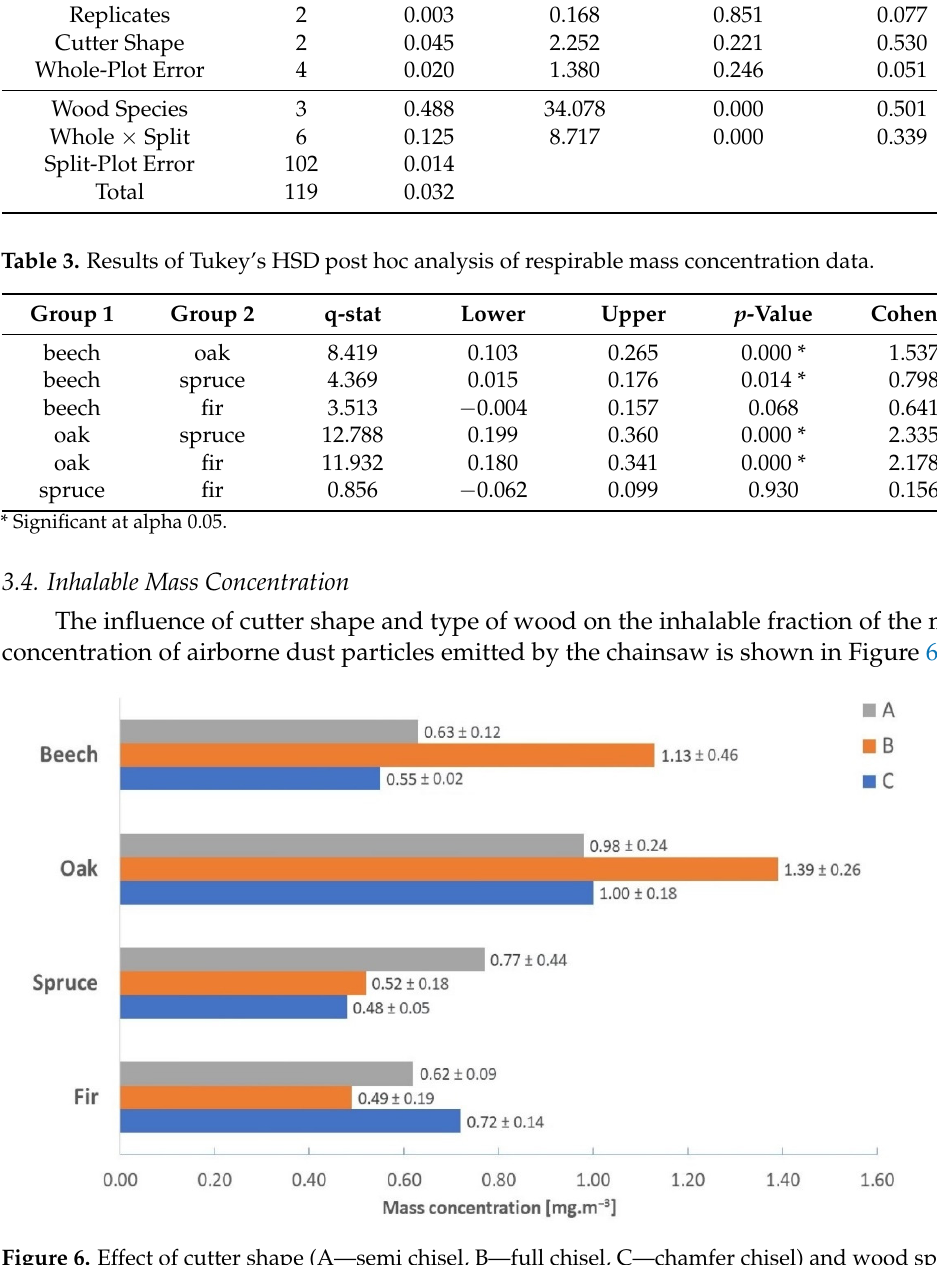
Figure 6. Effect of cutter shape (A—semi chisel, B—full chisel, C—chamfer chisel) and wood species on inhalable mass concentration (arithmetic mean ± standard deviation, n = 10).